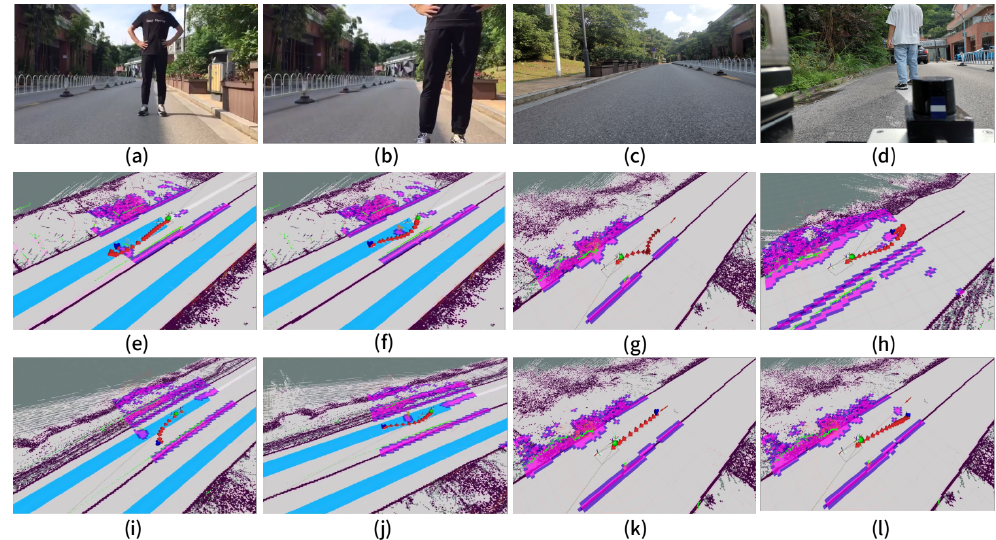
Figure 16. Real-world experimental results. ( a – d ) Are the pictures captured by the camera, ( a , b ) per- form obstacle avoidance tests with pedestrians. ( c , d ) Are taken by the camera fixed on the back of the AGV. ( d ) Is used to test reverse obstacle avoidance. ( e – h ) Are the screenshots taken from Rviz when running TEB planner. ( i – l ) Are the screenshots when running the NRTEB